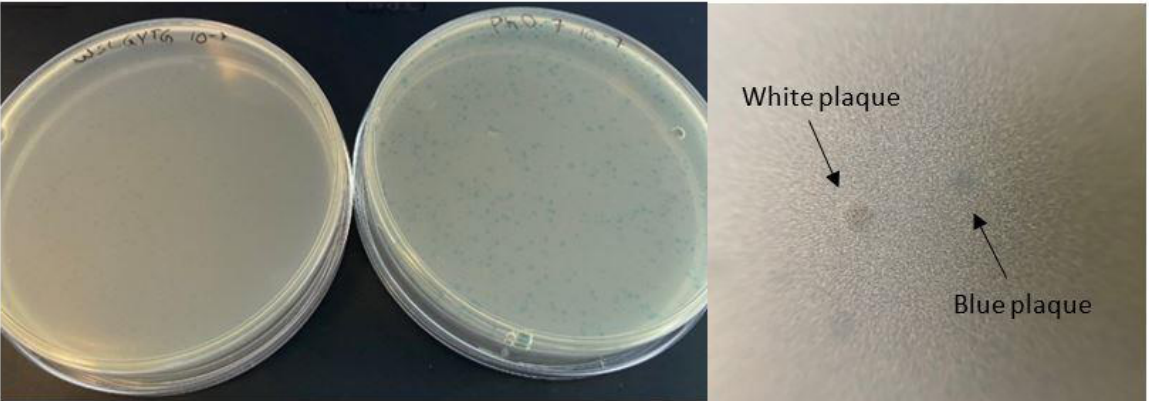
Figure 1. Plaques from WSLGYTG-displaying phage (left plate) and Ph.D. TM -7 peptide library (right plate) plated on separate plates and a close-up of a white and a blue plaque. WSLGYTG-displaying clone produces white plaques, whereas library clones produce blue plaques.